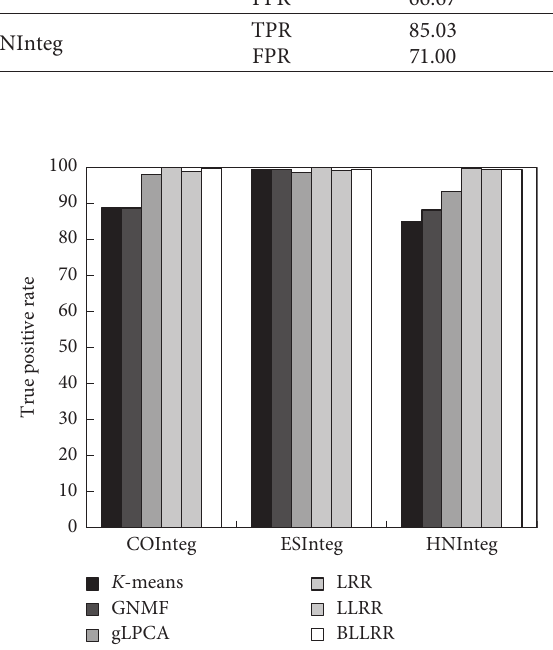
Figure 4: The false positive rates of six methods on each multi- genome data.